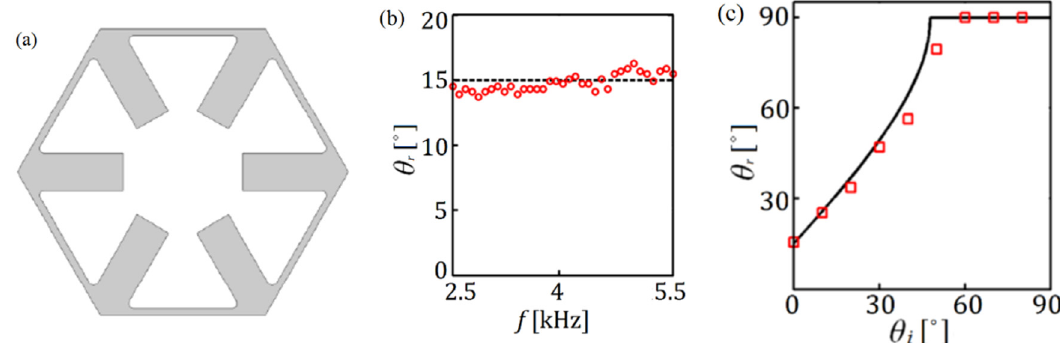
Fig. 4. (a) Schematic pentamode unit. (b) Relationship between working frequency and refractive angle. (c) Relationship between angles of incidence